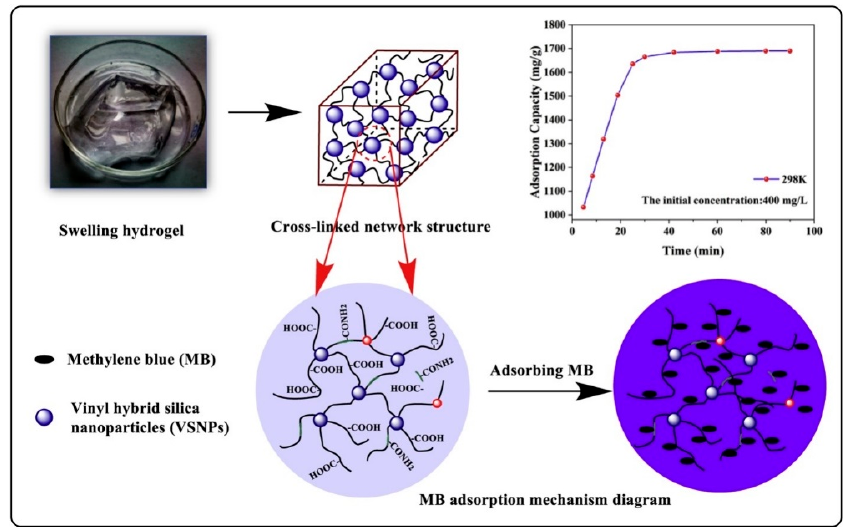
Figure 4. A novel super-adsorbent nanocomposite (NC) hydrogel adsorbent. In this study, a PAA [poly(acrylic acid)]-based hydrogel was prepared by vinyl hybrid silica nanoparticles (VSNPs) with average diameter of 30 nm as crosslinking agent. This adsorbent can absorb methylene blue at a high concentration (1690 mg/g) within 90 min. Reproduced from [59] with permission, copyright Elsevier, 2021.